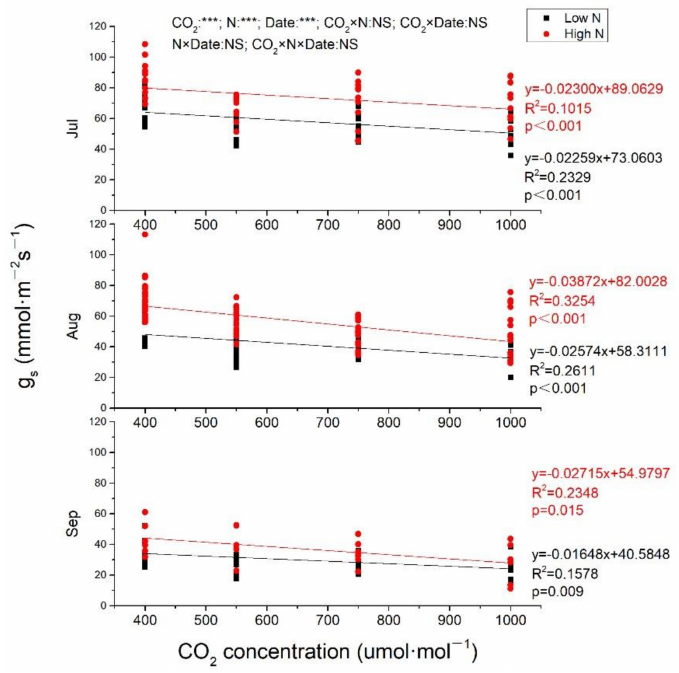
Figure 3. The effects of elevated CO 2 and N fertilization on stomatal conductance. g s , stomatal con- ductance. CO 2 : different CO 2 concentrations; N: N fertilization; Date: measuring date; ***: significant at 0.001 level; NS: not significant. Jul: July; Aug: August; Sep: September.